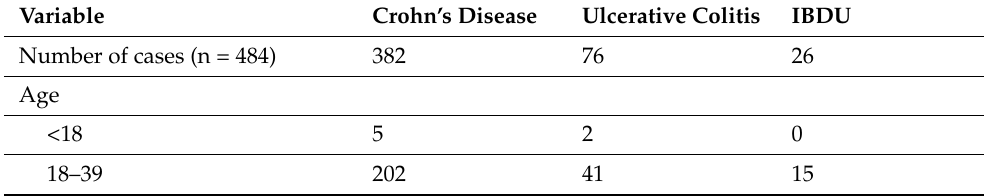
Table 2. The characteristics of the patients in stage 2 who completed the baseline CUCQ-12